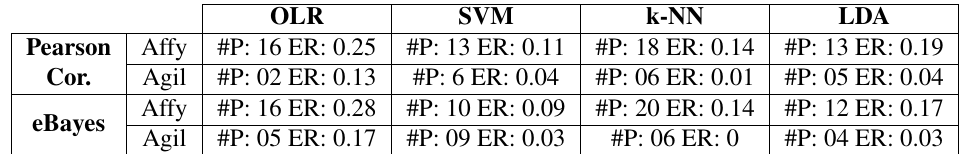
Table 4: Results for classifiers (columns), filtering methods (rows) at the probeset level. #P - number of probesets; ER - Error Rate